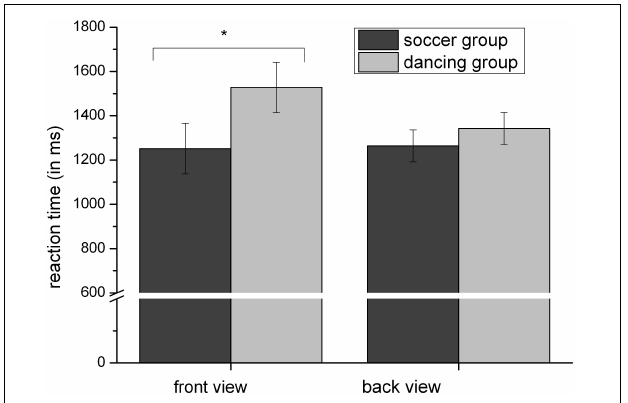
FIGURE 3 | Reaction time (Mean and SE) dependent on group and view: soccer-players show significantly faster reaction times (RTs) for front view stimuli compared to dancers. ∗ Indicates a significant difference between both groups.